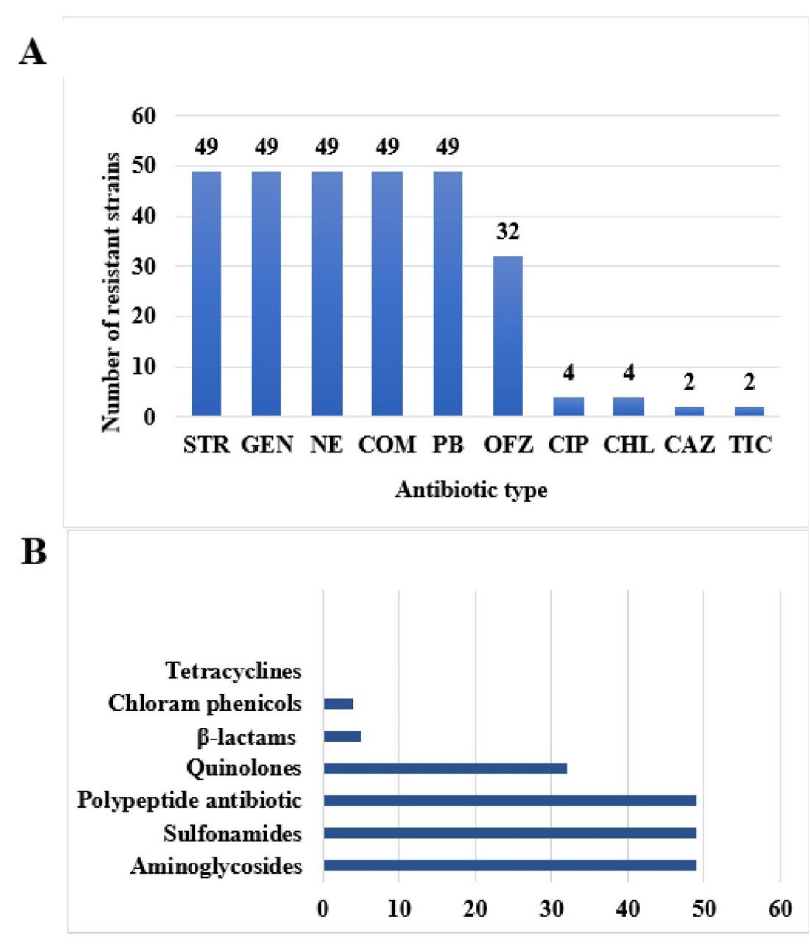
Figure 4. Distribution of drug resistance of 49 strains of T. halophilus . ( A ) Number of bacterial strains —by type of antibiotic; ( B ) Number of bacterial strains —by categories of antibiotic.